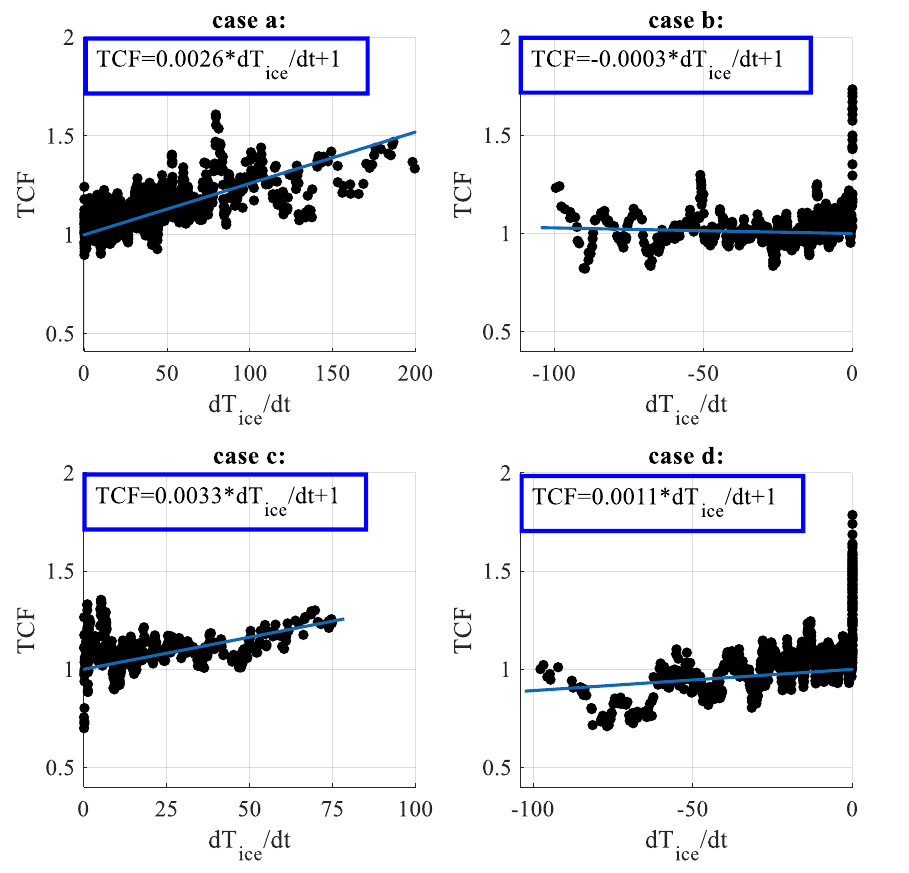
> 0 and dT ice > 0; Figure 3. TCF vs. torque changing rate of the engine in 4 cases: ( a ) d ω ice > 0 and 𝑑𝑇 𝑖𝑐𝑒 > 0 ; ( b ) Figure 3. TCF vs. torque changing rate of the engine in 4 cases: ( a ) 𝑑𝜔 𝑖𝑐𝑒 dt dt 𝑑𝑡 𝑑𝑡 > 0 and dT ice < 0; ( c ) d ω ice ≤ 0 and dT ice > 0 ( d ) d ω ice ≤ 0 and dT ice ≤ 0. ( b ) d ω ice 𝑑𝜔 𝑖𝑐𝑒 > 0 and 𝑑𝑇 𝑖𝑐𝑒 < 0 ; ( c ) 𝑑𝜔 𝑖𝑐𝑒 ≤ 0 and 𝑑𝑇 𝑖𝑐𝑒 > 0 ; and ( d ) 𝑑𝜔 𝑖𝑐𝑒 ≤ 0 and 𝑑𝑇 𝑖𝑐𝑒 ≤ 0 . dt dt dt dt dt dt 𝑑𝑡 𝑑𝑡 𝑑𝑡 𝑑𝑡 𝑑𝑡 𝑑𝑡